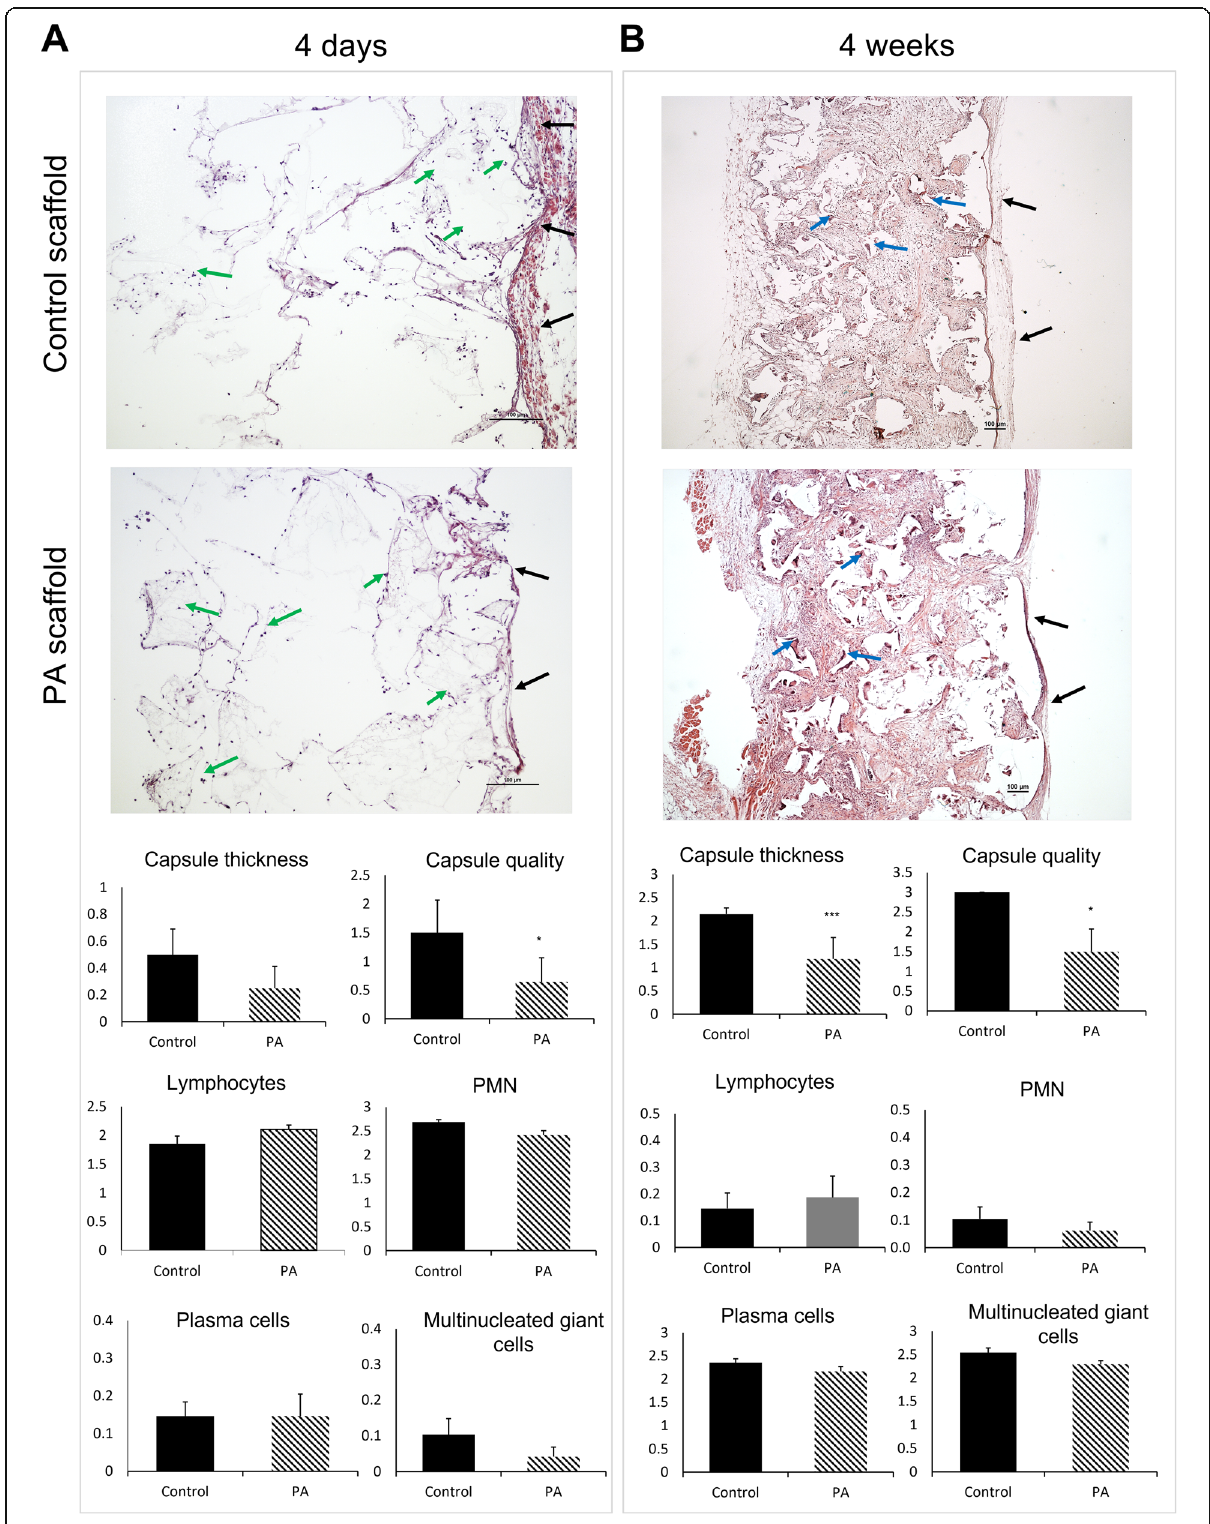
Fig. 4 (See legend on next